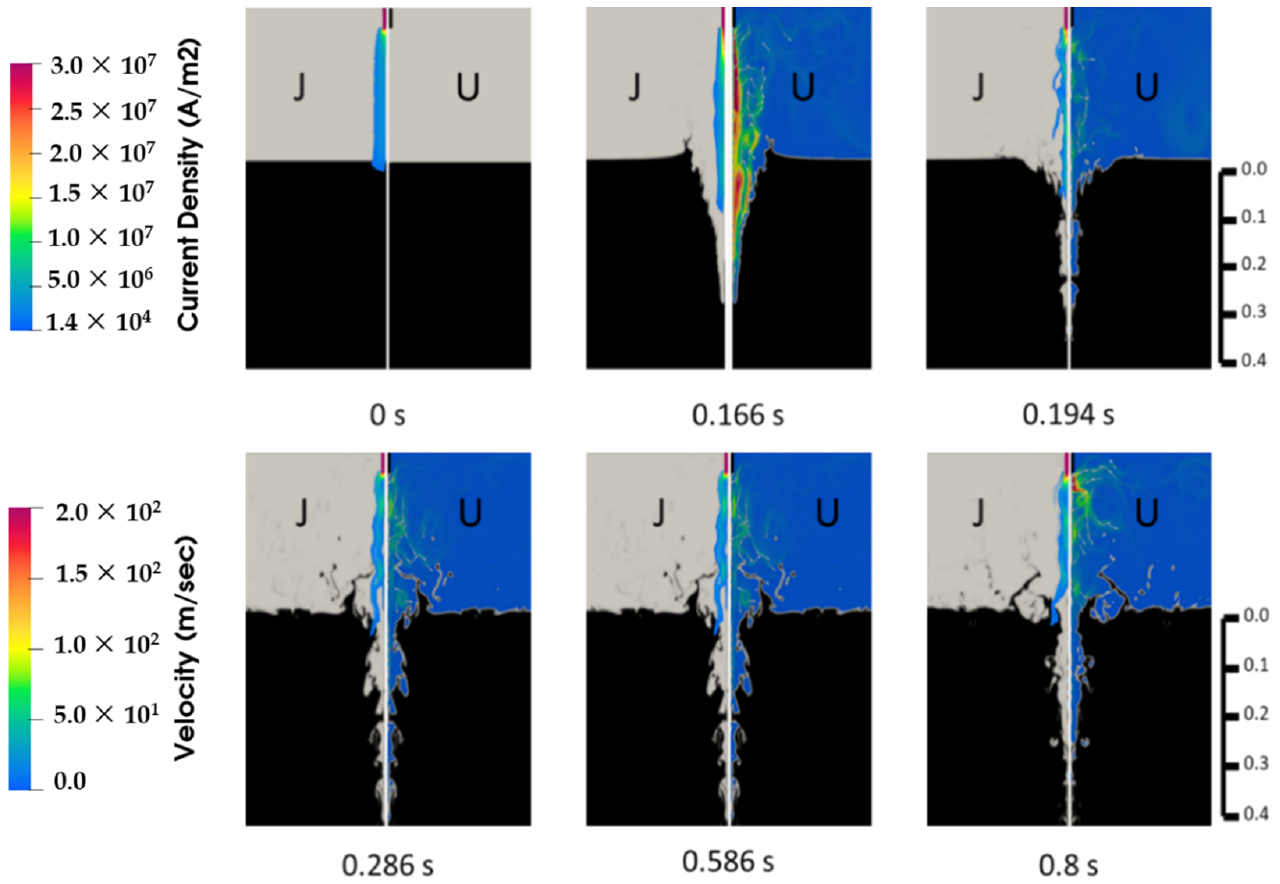
Figure 7. Arc impingement arc gap of 2.5 × 10 −1 m.